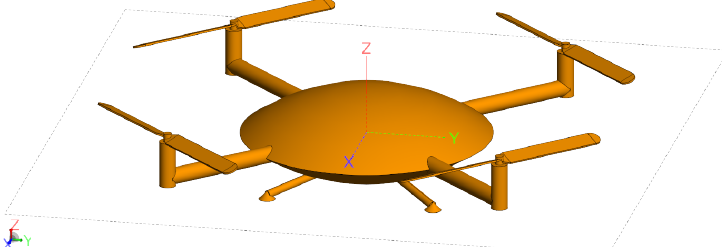
Figure 3. The 3D model of drone electromagnetic